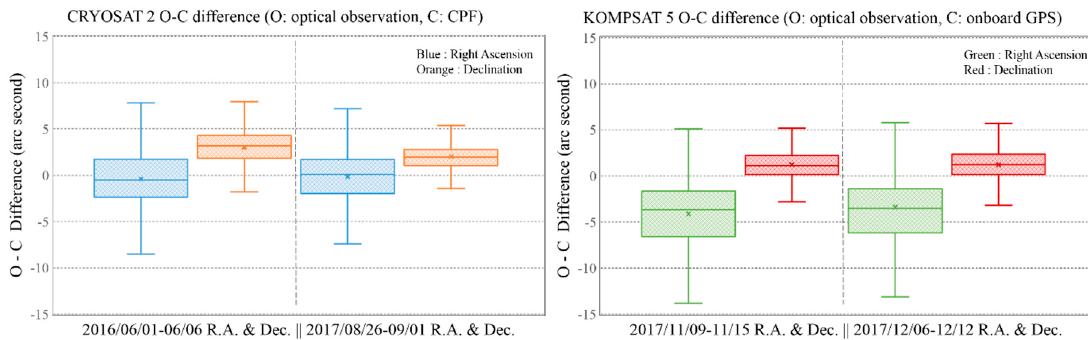
Figure 5. Box and whisker plot comparison for the 1-week O-C difference between optical observation data and precise orbit ephemeris (CPF and Precise Orbit Determination (POD) with onboard GPS data) for CRYOSAT 2 and KOMPSAT 5. The left graph for CRYOSAT 2 was the result of the comparison with CPF for 2 weeks in 2016 and 2017. The optical observation for KOMPSAT 5 in the right-side graph were compared with POD with onboard GPS data.